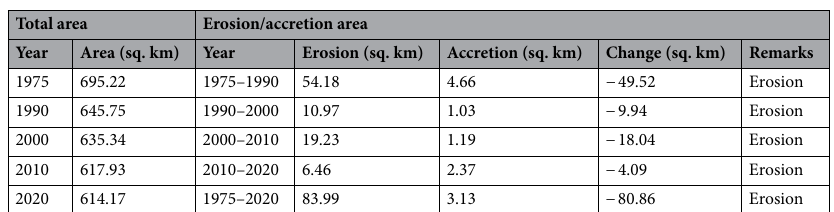
Table 9. Total shoreline and erosional and accretional areas in different time